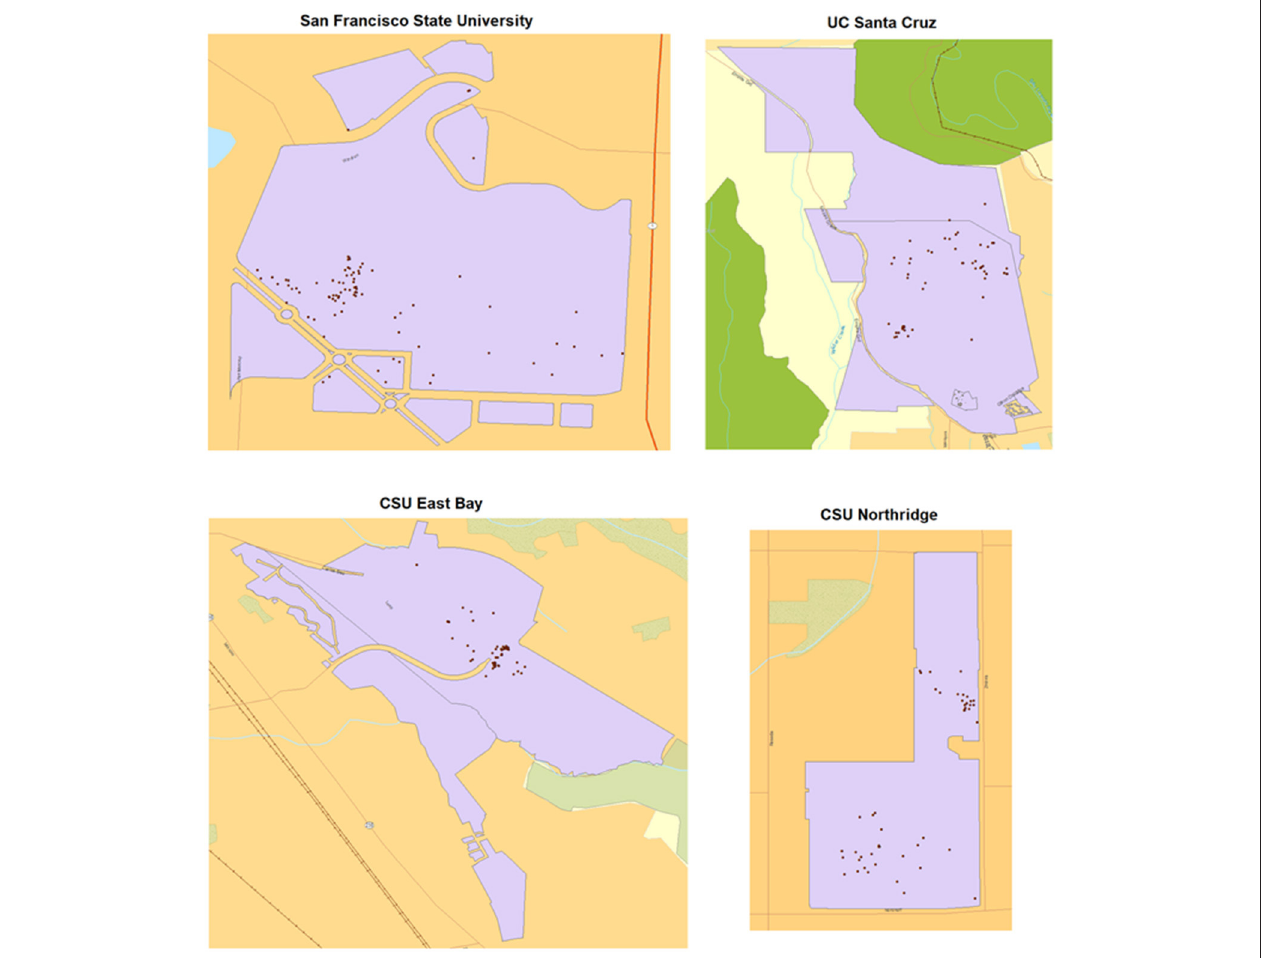
FIGURE 1 | Locations of Twitter posts from the top four colleges by volume of smoking-related tweets, with purple polygons denoting university lands, and dots representing tweet